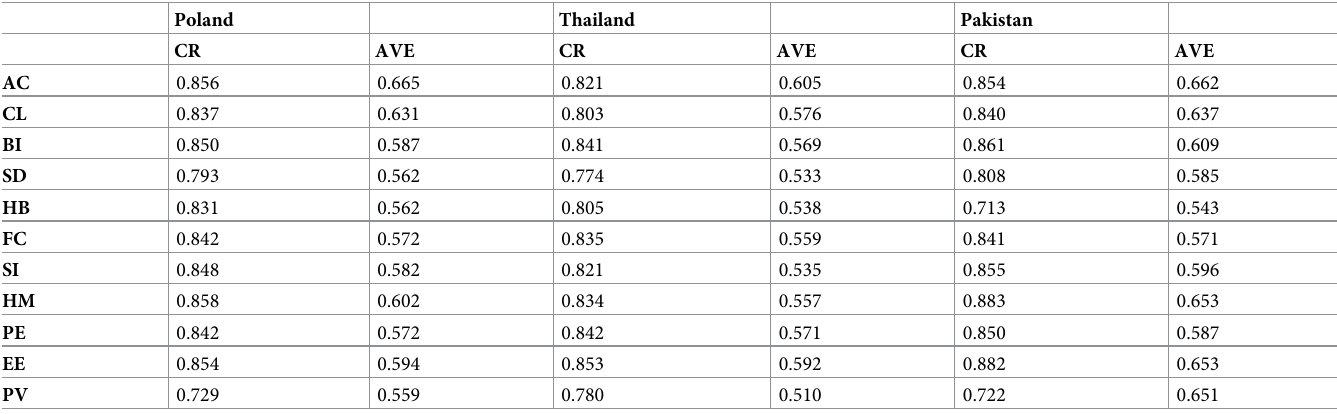
Table 4. Reliability and validity